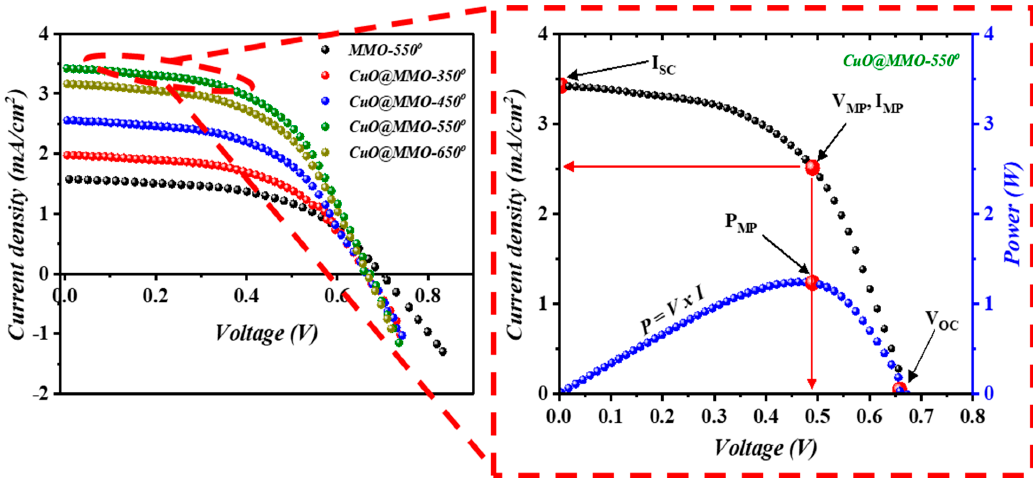
Figure 6. I-V characteristics of the DSSC devices; inset is the current density and power variation as a function of voltage.